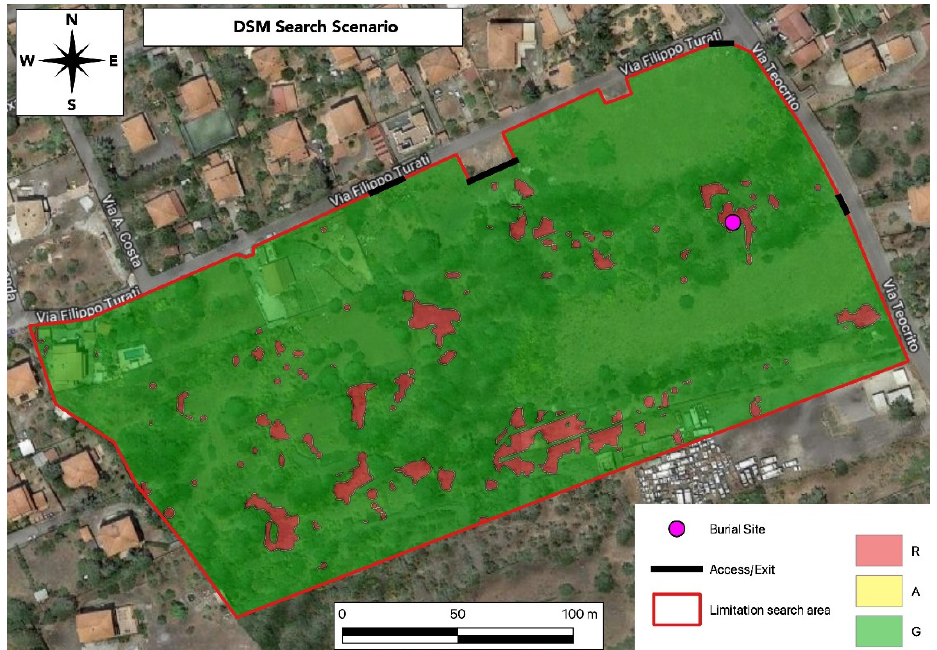
Figure 20. Histograms showing the percentages for each search scenario. Legend: R: Red code, A: Amber code, G: Green code. DSM visibility: DSM Search scenario, No visibility: Search scenario without visibility.